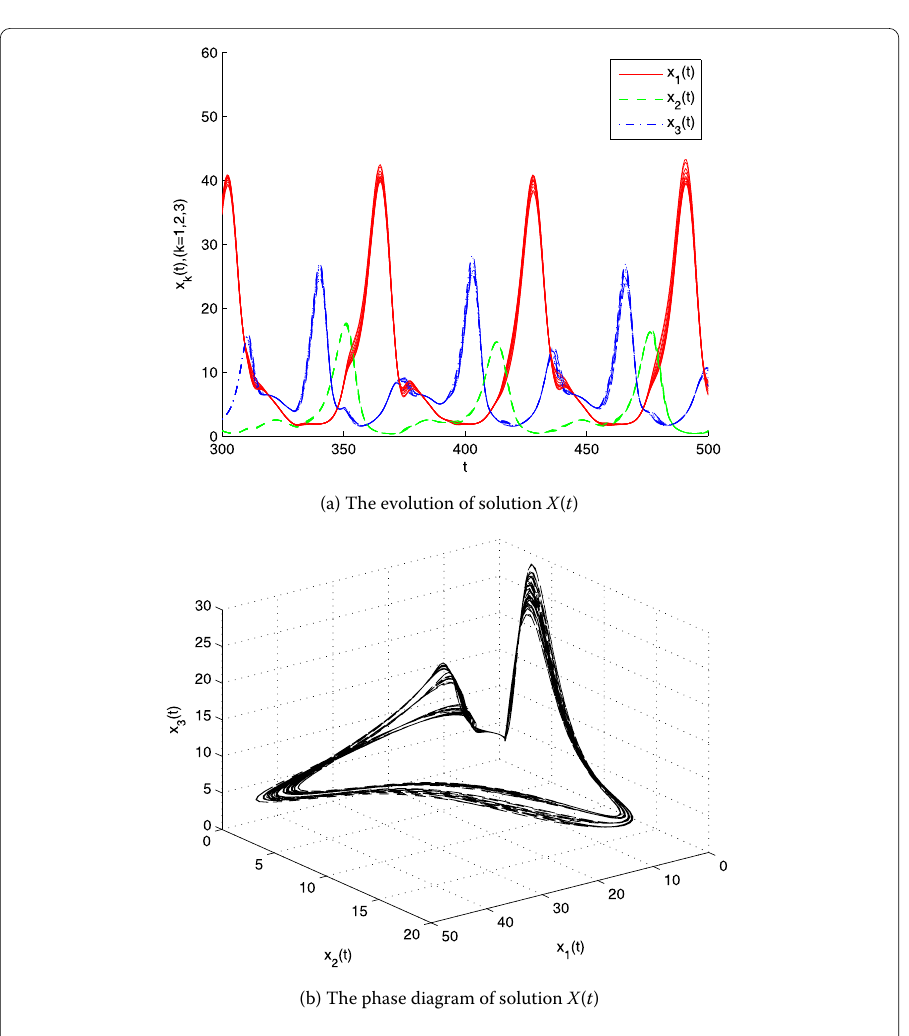
Figure 2 The non-asymptotic stability of the periodic solution ˜ X ( t ) of equation (17)